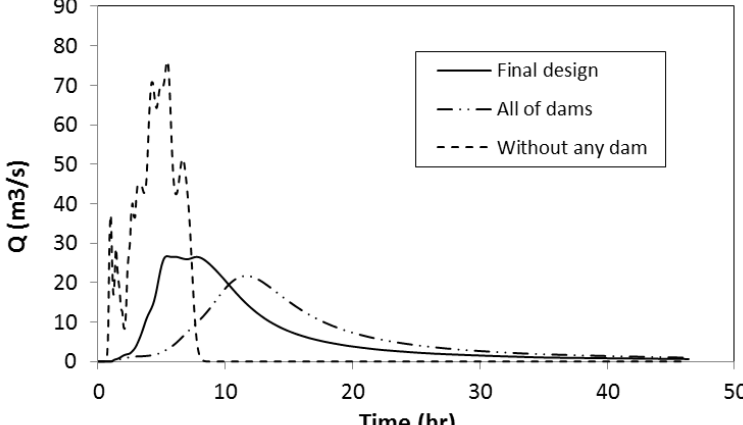
Figure 8 . Comparison of the final design hydrograph with two special modes of table 4